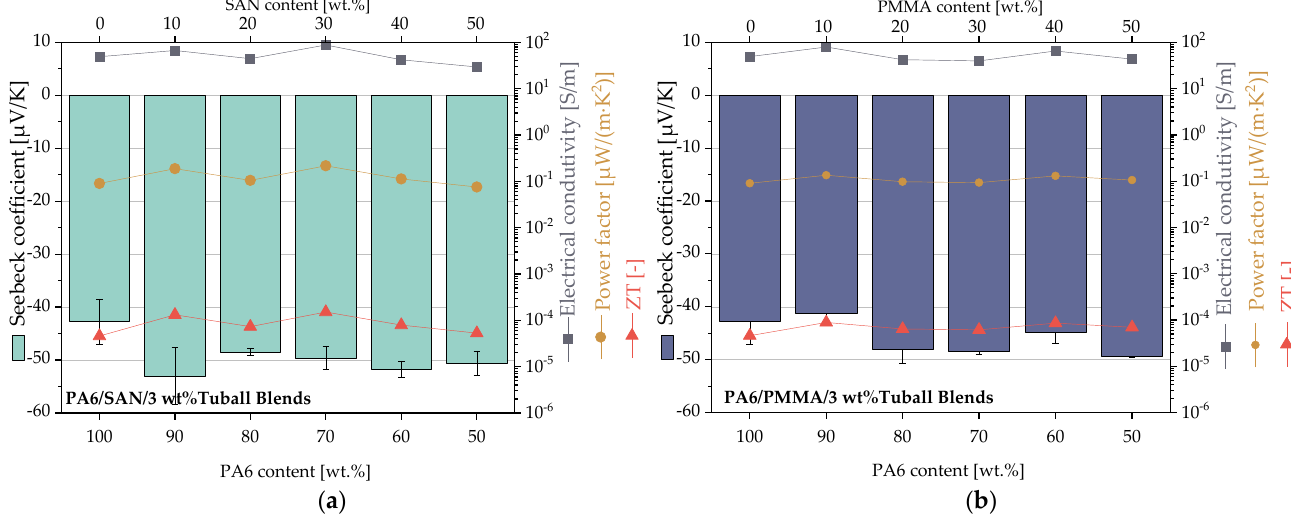
Figure 10. Thermoelectric parameters of ( a ) PA6/SAN/3 wt.% SWCNT blends and ( b ) PA6/PMMA/3 wt.% SWCNT blends having different ratios of the blend components (values are given in Tables A2 and A3).